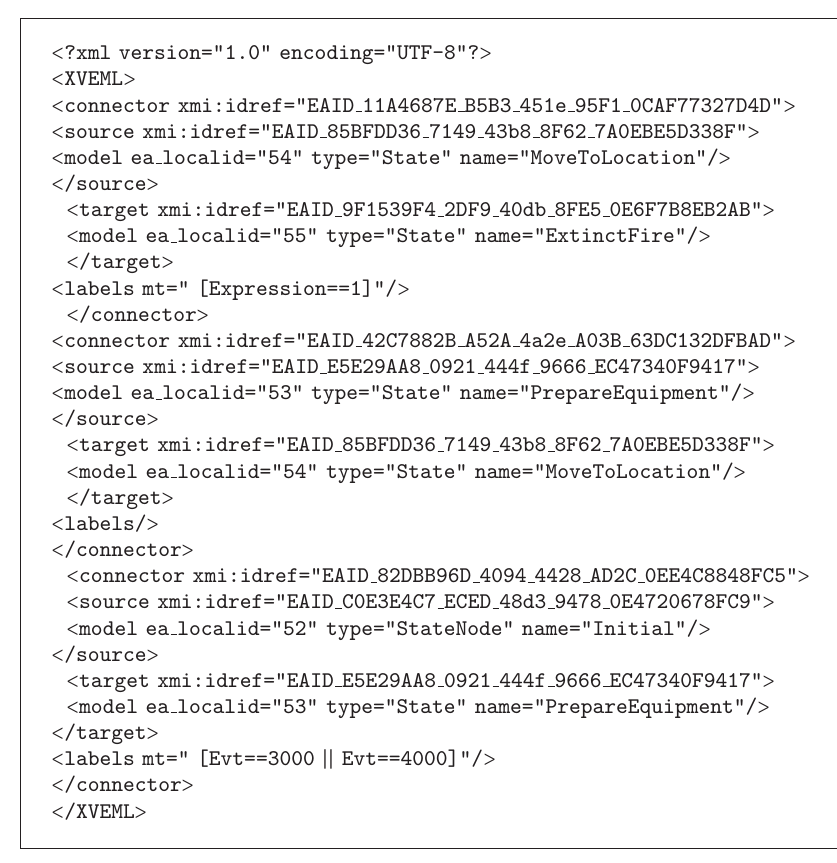
Algorithm 1: SCXML script